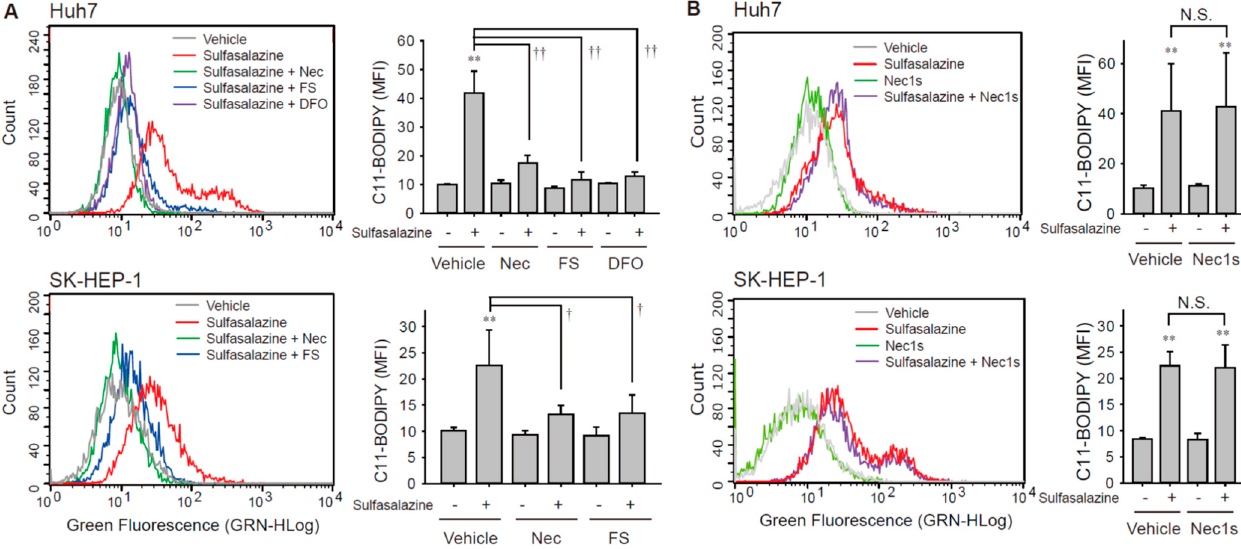
Figure 3. Necrostatin-1 blocked sulfasalazine-induced accumulation of lipid peroxidation. ( A ) Vehicle or 500 μ M sulfasalazine were applied to Huh7 cells for 18 h or to SK-HEP-1 cells for 24 h after treatment with 20 μ M necrostatin-1 (Nec), 20 μ M ferrostatin-1 (FS), or 100 μ M deferoxamine (DFO) for 1 h ( n = 3). ( B ) After pretreatment of 20 μ M necrostatin-1s (Nec1s), cells were exposed to sulfasalazine as described in (A) in Huh7 cells ( n = 4) or SK-HEP-1 cells ( n = 3). Cells were sampled for staining with a C11-BODIPY probe and examined via flow cytometry. Representative images with selected groups are shown to avoid complication. Each experiment was independently repeated and data are expressed as means fluorescence intensity (MFI) ± SDs. ** p < 0.01, vehicle versus sulfasalazine; † p < 0.05, †† p < 0.01, sulfasalazine versus sulfasalazine with inhibitor; N.S., not significant.